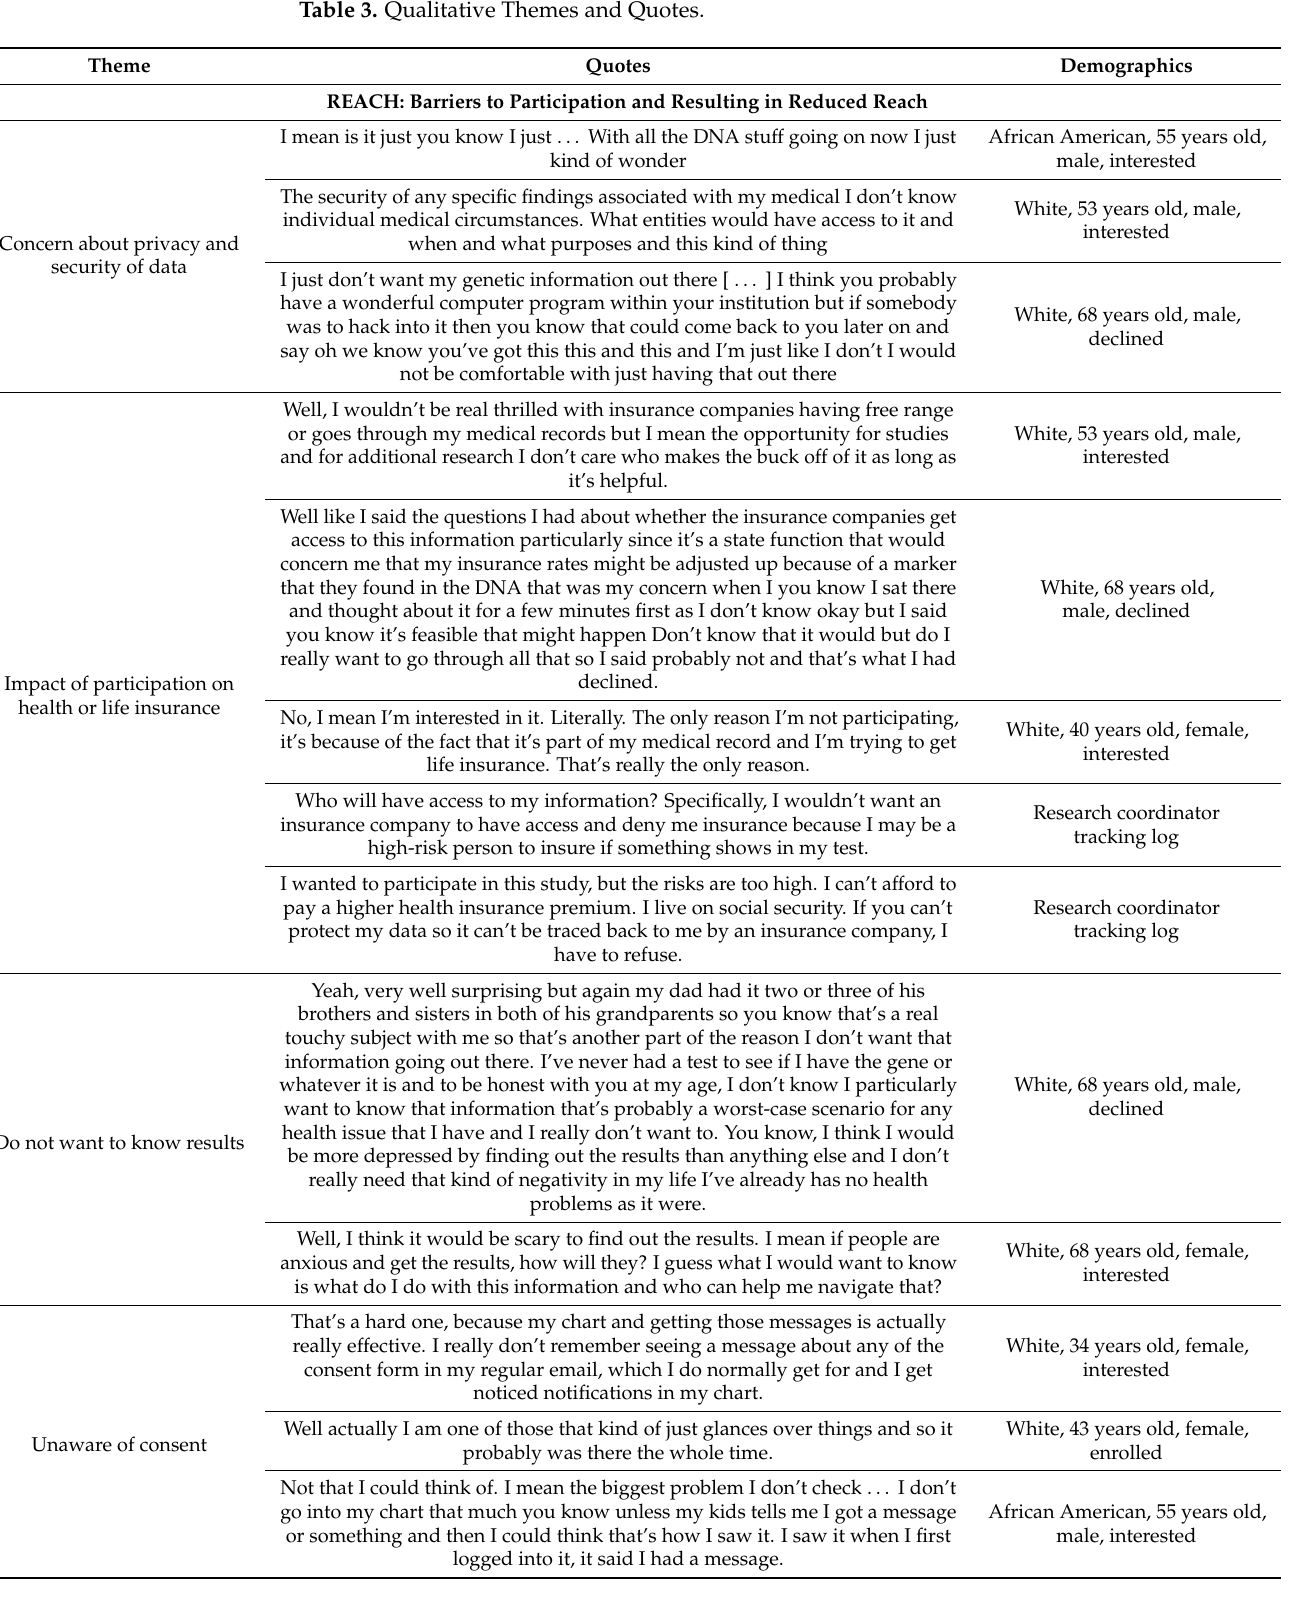
Table 3. Qualitative Themes and